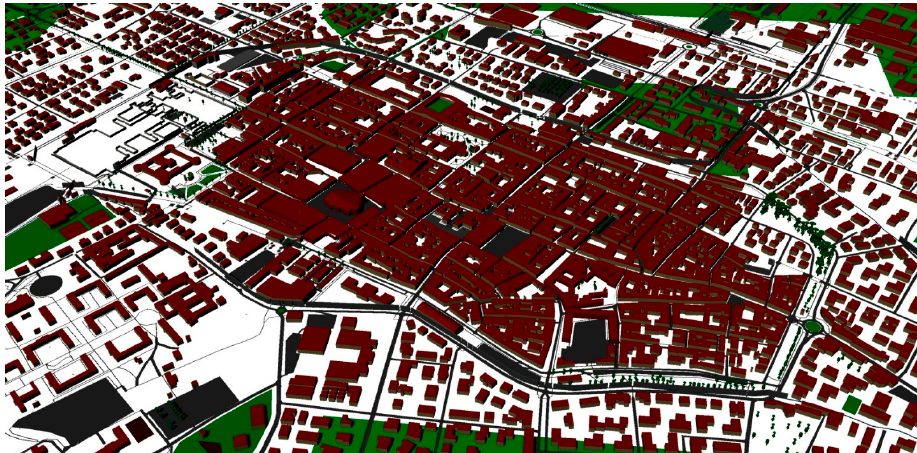
Figure 3. The 3-Dimensional model of the city including connection routes, buildings, and urban vegetation.